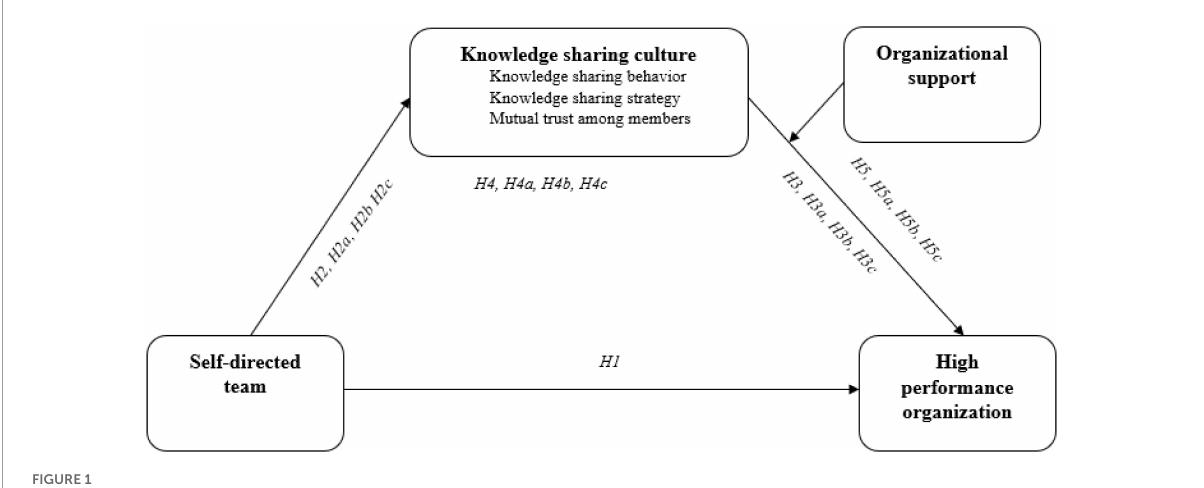
FIGURE1 Conceptual